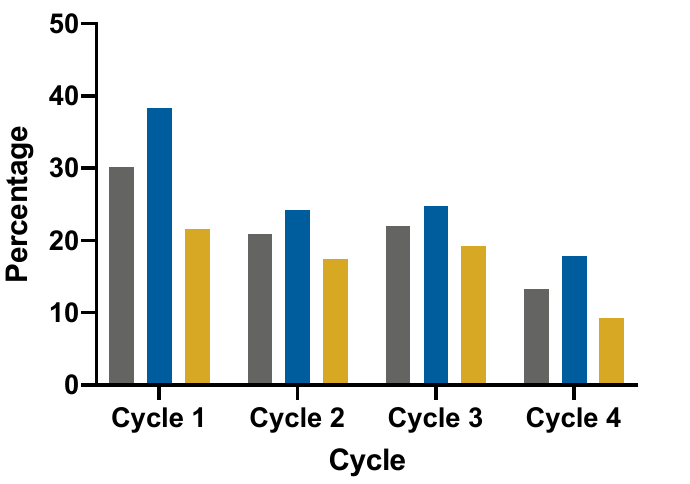
Figure 1. The rate of grade 3 or 4 neutropenia by different cycles and different regimens. Abbrevia- tions: EC = epirubicin and cyclophosphamide; TC = docetaxel and cyclophosphamide. More all-grade anemia was observed in EC group (42.86% vs. 22.96%, p < 0.001). Both groups experienced similar rates of all grade thrombopenia (7.14% vs. 4.44%, p = 0.49) and all grade hepatotoxicity (11.43% vs. 8.15%, p = 0.48). Grade 3 or higher anemia (1 vs. 0), thrombopenia (2 vs. 1) and hepatotoxicity (1 vs. 1) are rare in both groups (Table 3). Table 3. Other adverse hematological events.